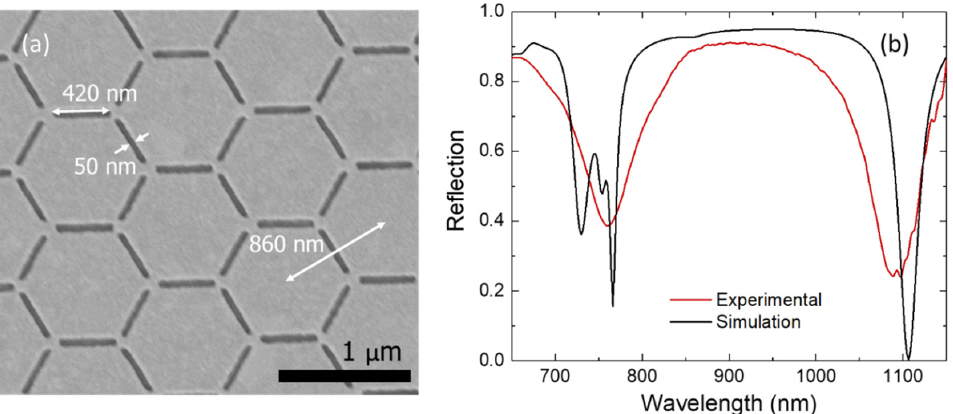
Figure 7. ( a ) SEM image of the manufactured sample. ( b ) Experimental (red curve) and simulated data (black curve) corresponding to the reflection spectrum as a function of the wavelength. The simulated curve is the same as in Figure 2 and is included here for the sake of comparison.